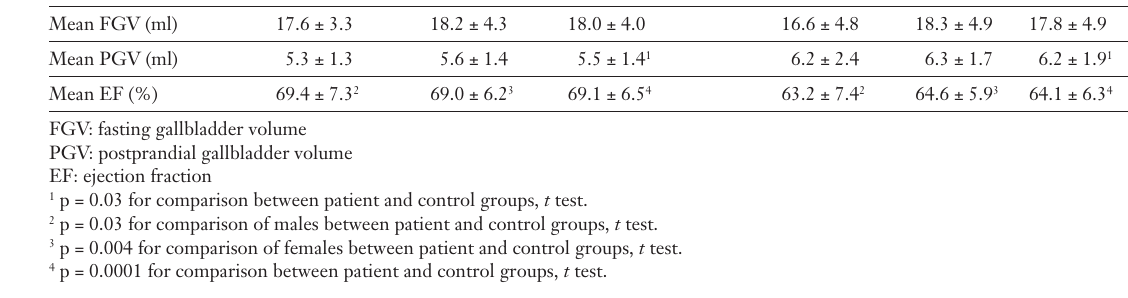
The mean FGV, PGV and EF values of gall- bladder in patients and control subjects (mean ± SD).